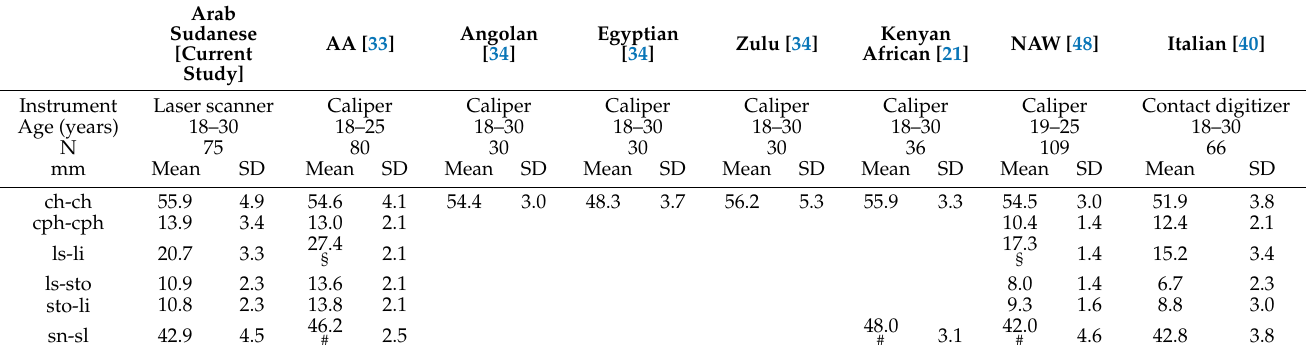
Table 5. Lip dimensions obtained in the current study and in the literature for young adult healthy African or African American men compared to data for Caucasoid